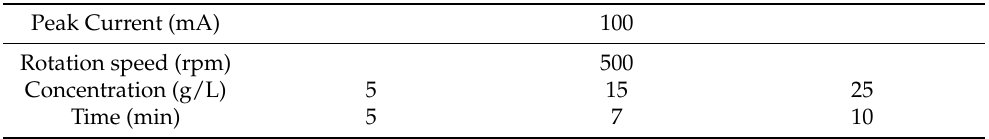
Table 2. Alumina particles concentration for